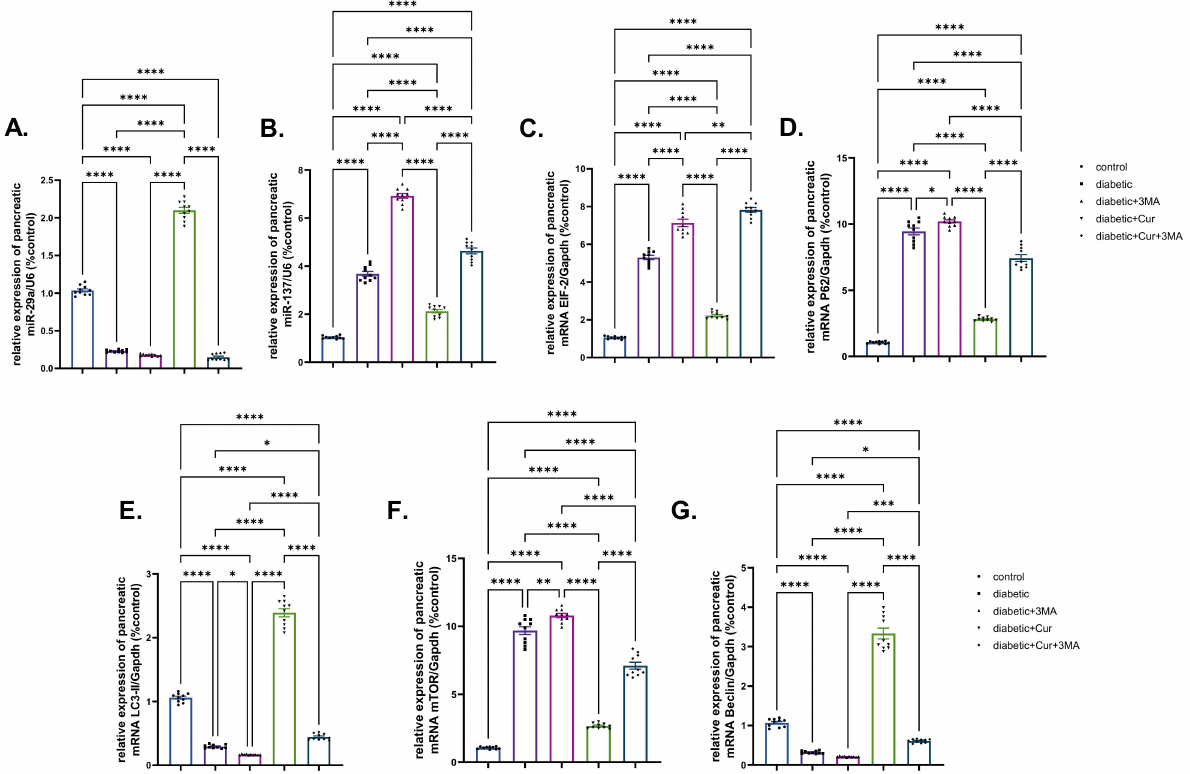
Figure 6. Effect of diabetes (STZ) (65 mg/kg b.wt), 3MA (10 mg/kg b.wt), LPs-CUR (10 mg/kg b.wt.) oral dosing for 10 weeks on the expression pattern (Fold change) of genes by qRT-PCR ( A ) mic-RNA mir-29b, ( B ) mir-137, ( C ) mRNA EIF-2, ( D ) mRNA P62 ( E ) mRNA LC3-II, ( F ) mRNA mTOR, and ( G ) Beclin-1 in pancreatic tissue of all diabetic and vehicle control groups. Data expressed as mean ± SE, n = 10 for each group. Each bar carrying the significance which may be significance which may be significant at * means when p < 0.05, ** means when p < 0.01, *** means when p < 0.001 and **** p <